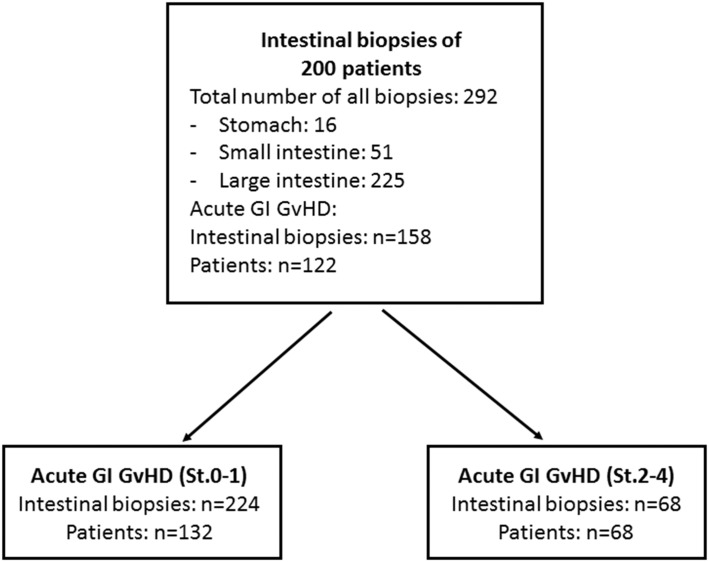
Flow chart describing the study design as well as biopsy numbers in all groups.